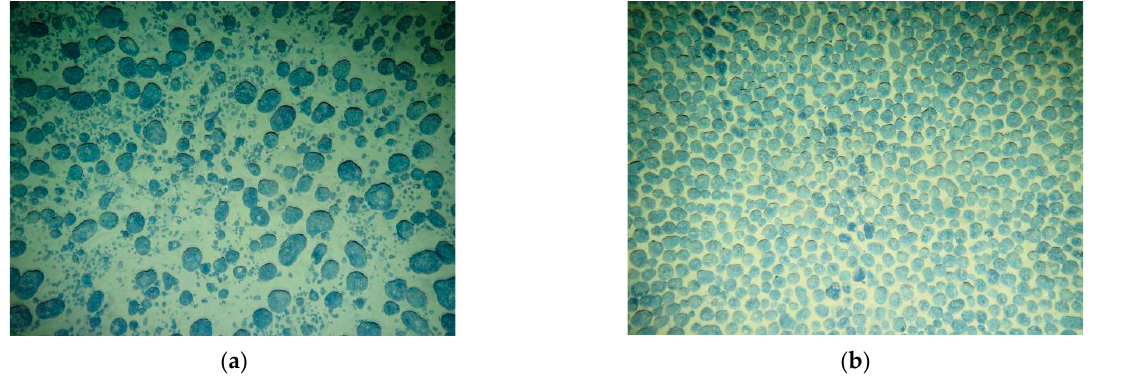
Figure 1. Photographic images of deep-sea polymetallic nodules, which was taken in the west Pa-